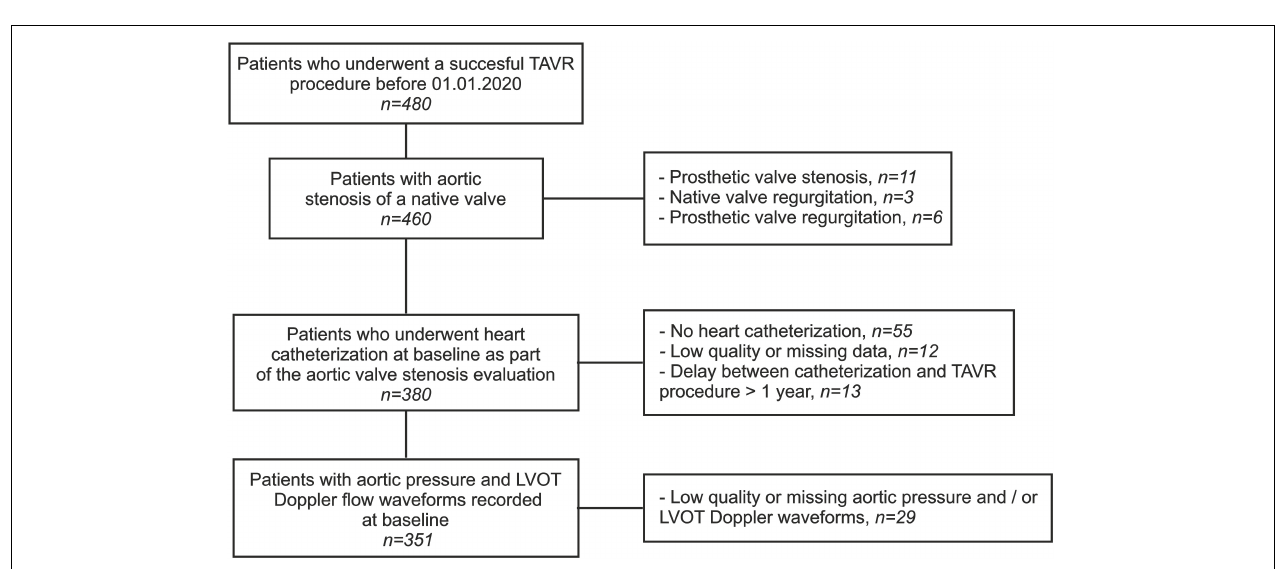
FIGURE 2 | Study flowchart. TAVR, transcatheter aortic valve replacement; LVOT, left ventricular outflow tract.